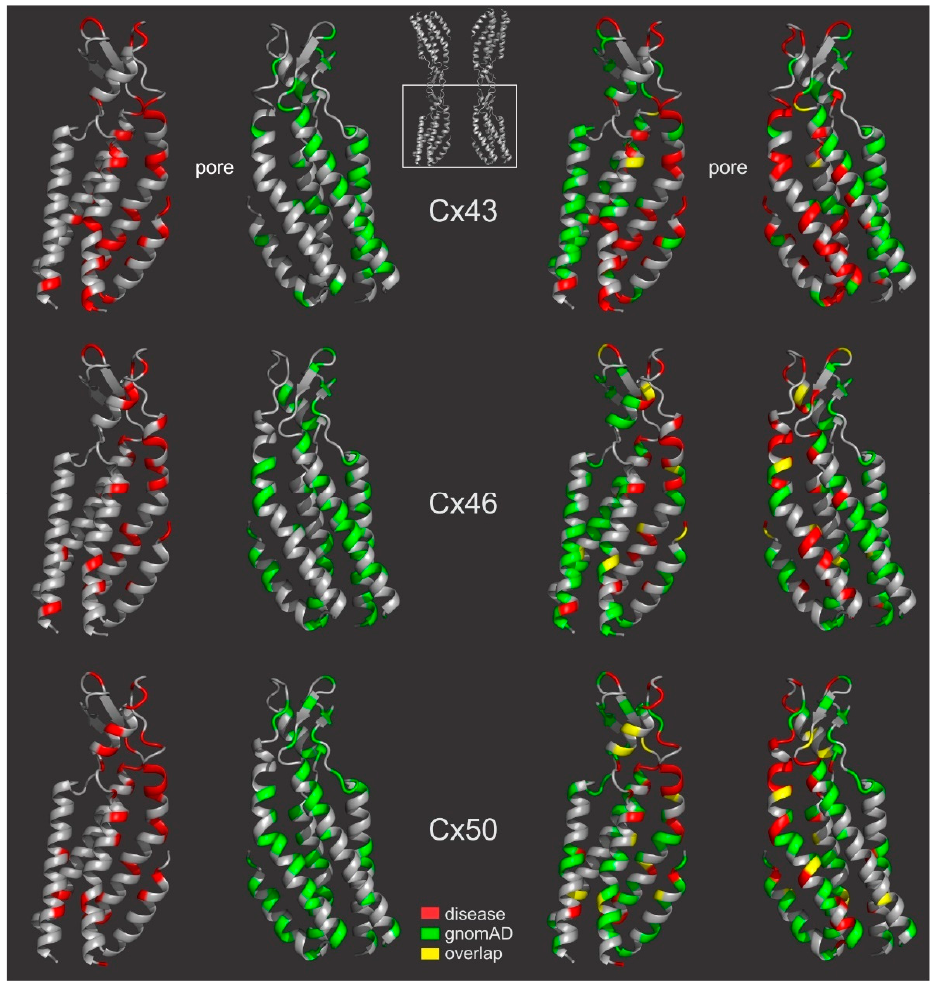
Figure 7. Disease- and gnomAD-linked missense variants are plotted on the gap junction structure. Homology structure models were developed for these connexins based on the Cx46 GJ structure (6MHQ) and the structure of the bottom two connexins as indicated are shown in cartoon view in the left panels to display the residues linking to diseases (red) or gnomAD (green) missense variant residue positions. Superimposed with both types of variants are shown on the right panels (overlapped residues are shown in yellow). A movie was generated to show these variants on 3D structure models (see supplementary movie).